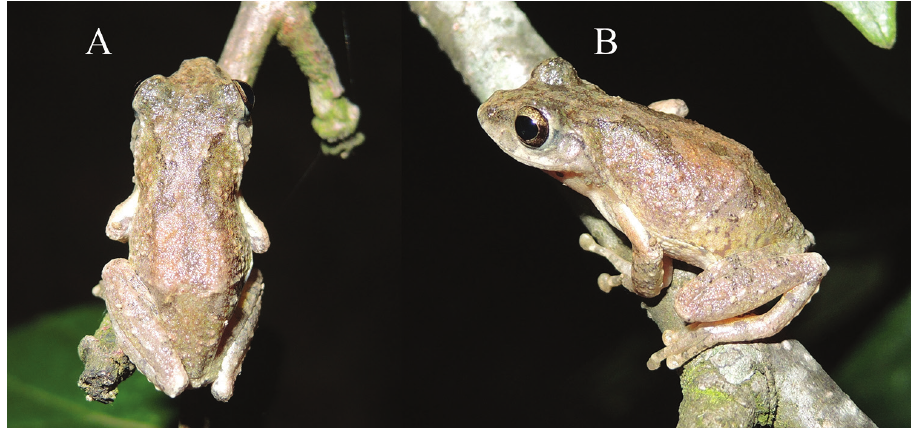
Figure 6. Dorsal A and lateral B views of the holotype of Kurixalus lenquanensis sp. n. in life.